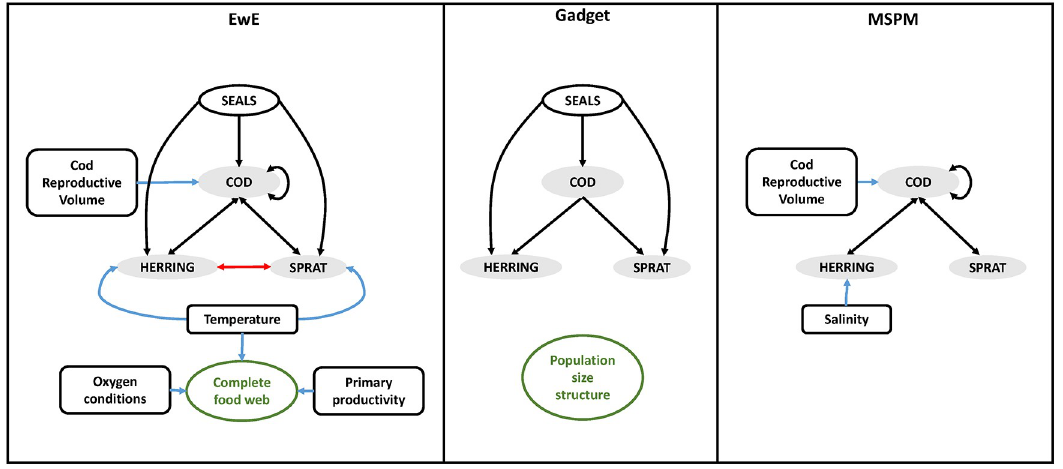
Fig 1. Model components and interactions in (A) EwE, (B) Gadget and (C) MSPM models of the Baltic Sea ecosystem. Grey shaded ovals represent the three fish stocks included in all models. Green ovals denote components unique to a model. Black arrows represent predation, the red arrow competition, and blue arrows abiotic environmental effects. Single-headed arrows represent one- way interactions and double-headed arrows dynamic predator-prey feedbacks. Fitting periods for the models were 2004–2013 (EwE), 1974–2013 (Gadget) and 1982–2013 (MSPM). EwE and MSPM have yearly, while Gadget quarterly time